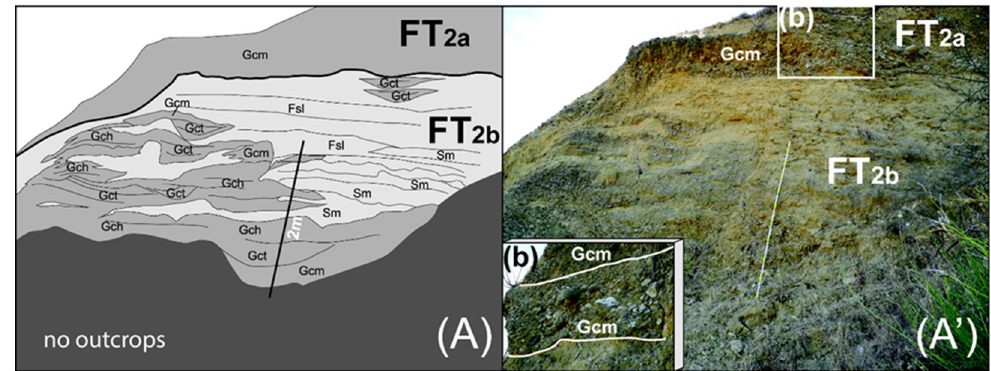
Figure 6. Depositional facies architecture of the Croce d’Anglona unit is shown in the cartoon ( A ) and in the field view ( A’ ). The box (b) is a detail of the FT 2 upper sequence. See Table 1 for facies code and interpretation.